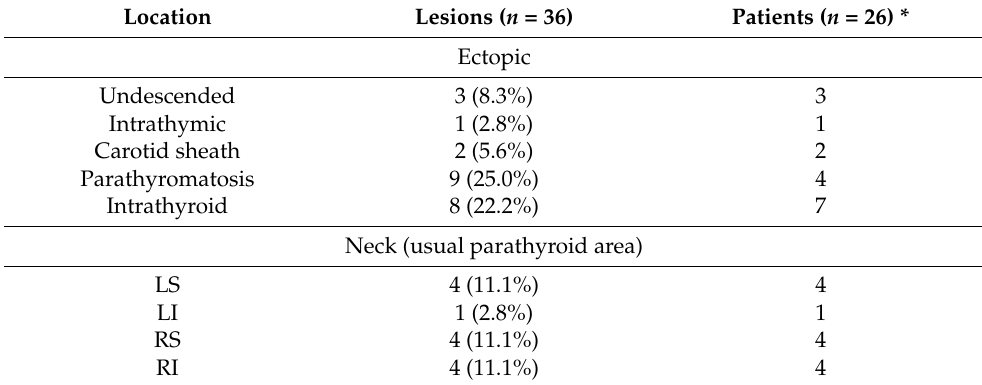
Table 3. Location of parathyroid lesions removed during